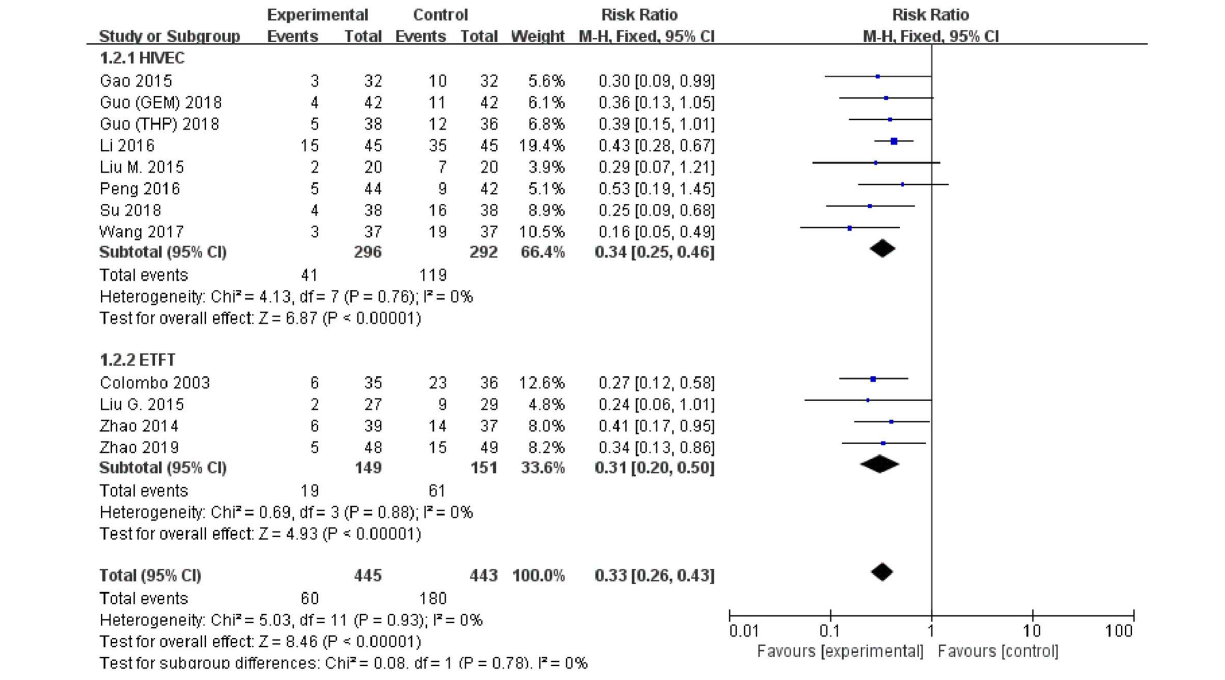
Frontiers in Oncology |